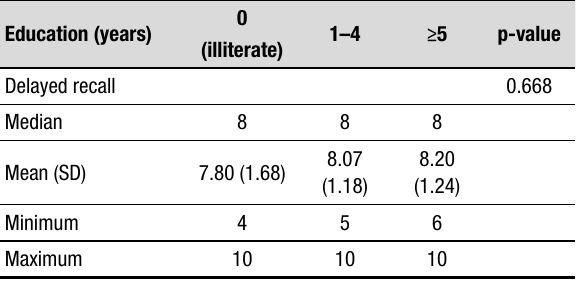
Table 2. Delayed recall of the Figure Memory Test of the Brief Cognitive